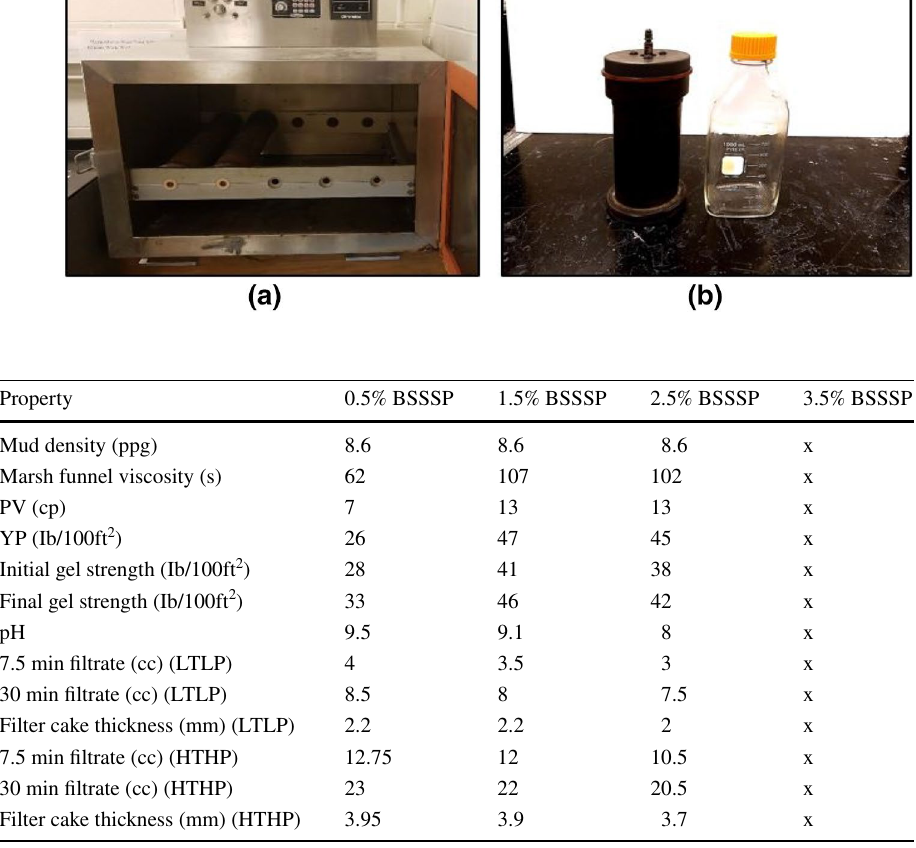
Fig. 5 a Roller oven and acces- sories, and b aging cell and accessories